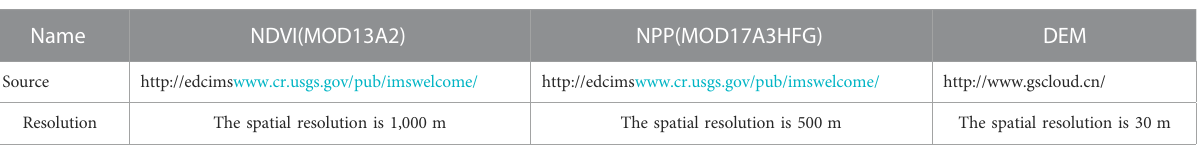
TABLE 1 Data source statistical